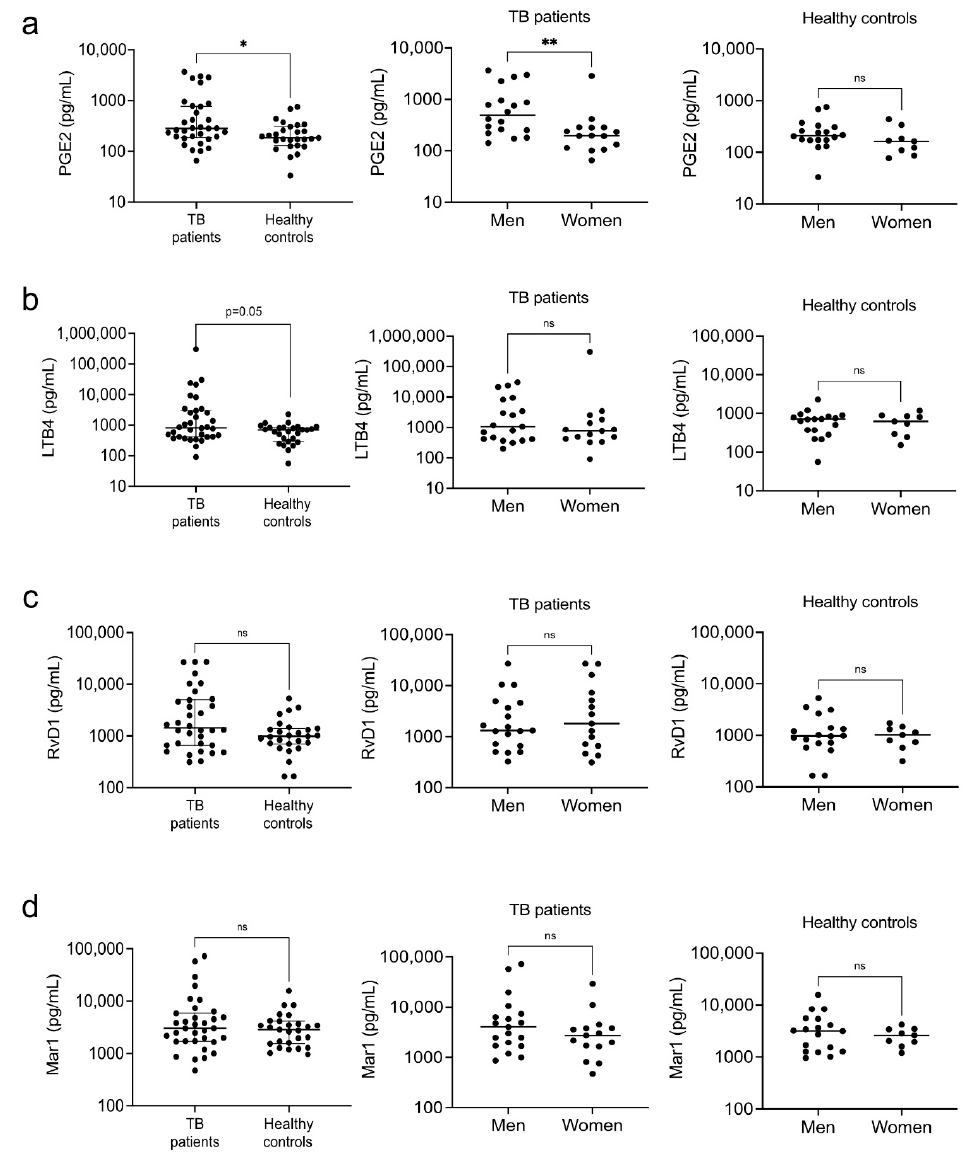
Figure 3. Circulating levels of eicosanoids. Serum levels of proinflammatory PGE2 ( a ) and LTB4 ( b ) eicosanoids and pro-resolutory RvD1 ( c ) and Mar1 ( d ) eicosanoids were measured in patients with pulmonary tuberculosis and healthy controls by ELISA. Individual results with medians and interquartile ranges are depicted ( left ). Data were disaggregated by sex for both the patients ( center ) and controls ( right ); individual results with medians are depicted. * p < 0.05, ** p < 0.01, ns = not significant. Because disease severity in TB has been reported to be associated with an increased ratio of LXA4/LTB4 and a reduced ratio of PGE2/LXA4, rather than changes in